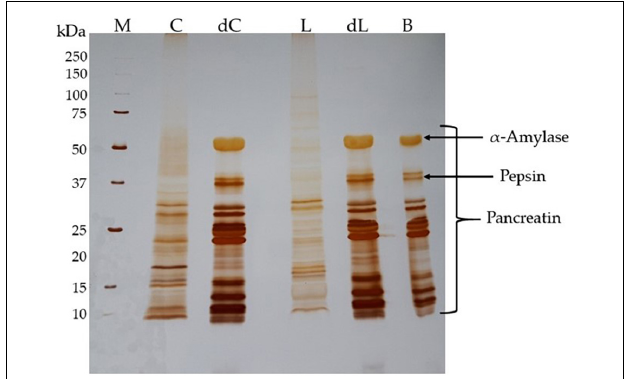
FIGURE 2 | Protein hydrolysis after in vitro digestion. Silver-stained SDS-PAGE gel (17.5% w/v polyacrylamide) ran under reducing conditions. Expected molecular weights are indicated for the molecular weight standards. The quantity of protein loaded in each lane is 15 µ g for chickpea and lupin beverages, and 7 µ g for both digesta and enzyme-blank control. M, protein molecular weight markers; C, chickpea beverage polypeptides; dC, chickpea whole digesta polypeptides; L, lupin beverage polypeptides; dL, lupin whole digesta polypeptides; B, enzyme-blank control.